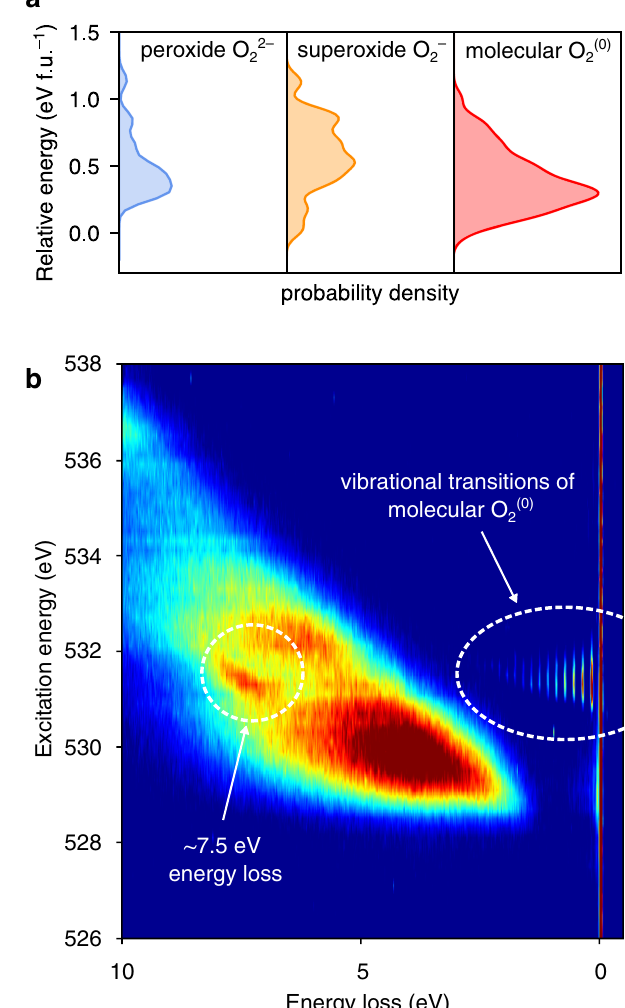
Fig. 3 | Computational and experimental evidence for molecular O 2 formation in charged Li 2 – x MnO 2 F. a Comparison of the stability of structures from the Mn rearrangement model, containing the different types of O – O dimers, classi fi ed according to bond length: (peroxide O 2 2 – (1.35Å ≤ d O – O <1.70Å), superoxide O 2 – (1.24Å ≤ d O – O <1.35Å)andmolecularO 2 ( d O – O <1.24Å).Thepanelsshowthekernel density estimations of the probability of energies for the classi fi ed structures. The energies were calculated relative to the most stable con fi guration from the entire search. Thus, zero energy corresponds to the most stable obtained from the Mn rearrangement model. Calculations used the SCAN functional. b High-resolution resonant inelastic X-ray scattering (RIXS) map of Li 2 – x MnO 2 F charged to 5.0V, showing the vibrational features corresponding to molecular O 2 only, and an energy loss feature at ∼